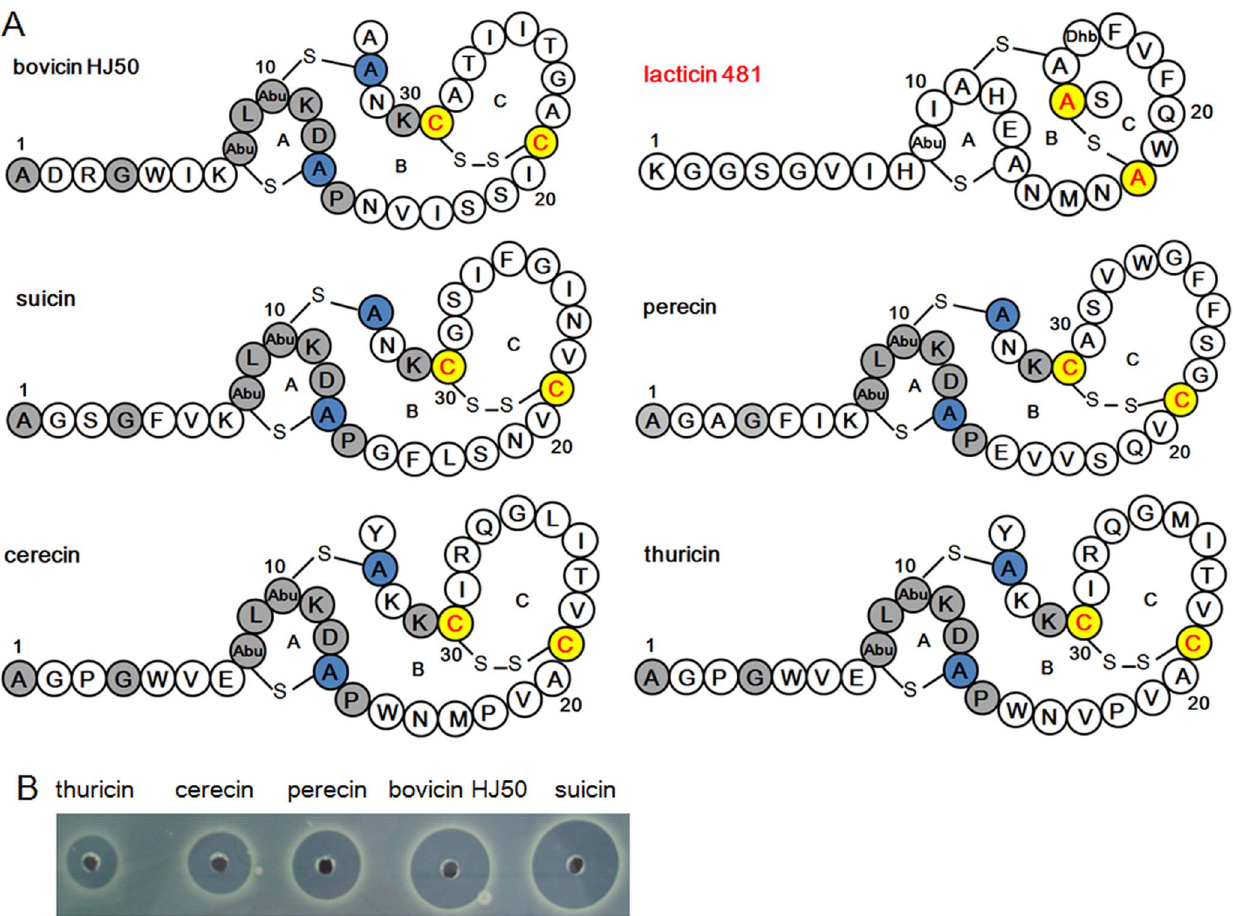
Figure 3. Structure and antimicrobial activity of bovicin HJ50-like lantibiotics. (A) Comparison of structure of bovicin HJ50-like lantibiotics with lacticin 481. Gray residues indicated identical amino acids and the Cys residues in red of yellow background indicated disulfide-forming Cys in bovicin HJ50, suicin, perecin, cerecin and thuricin. (B) Comparison of antimicrobial activity of bovicin HJ50-like lantibiotics. In each hole, 25 m L of 10 m g/mL compounds were applied.